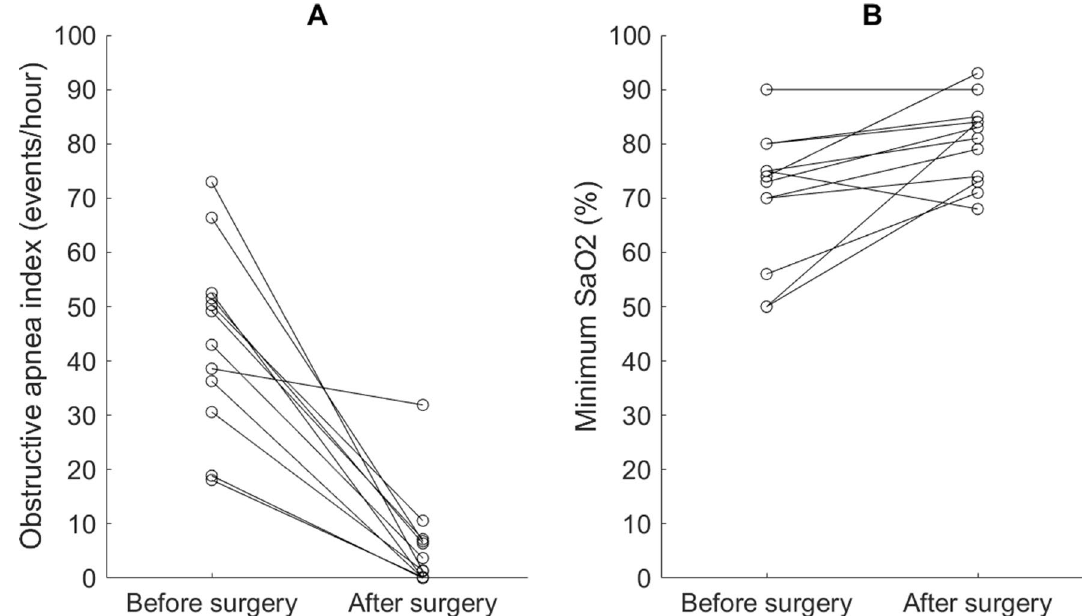
Figure 4. Individual change of obstructive apnea index ( A ) and minimum O2 saturation ( B ). p < 0.01 in both